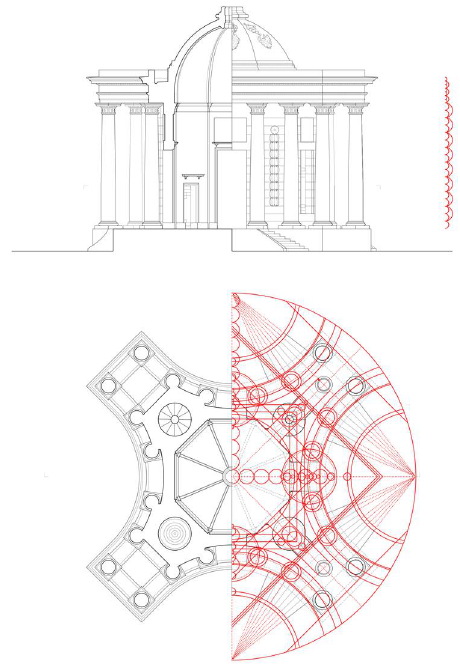
Figure 5. Section/Front and typography/plan with the superposition of the.